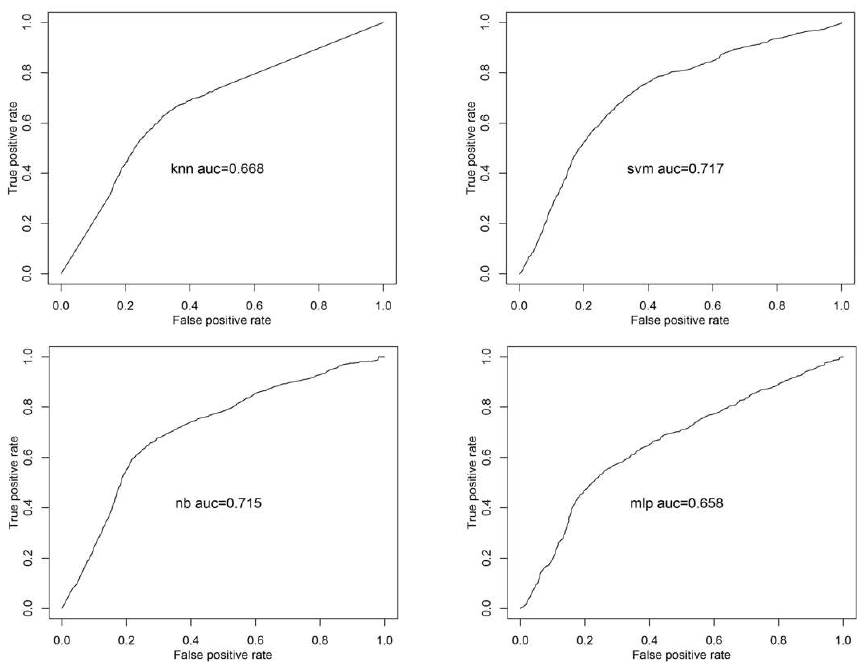
Figure 2. Receiver operating characteristic (ROC) curves for malicious intention detection based on using k-nearest neighbor (kNN), support vector machine (SVM), naïve Bayes (NB) and multilayer perceptron (MLP) classifiers with the Variable Selection Using Random Forests (varSelRF) algorithm. Table 4. Average classification accuracy for malicious intention detection.